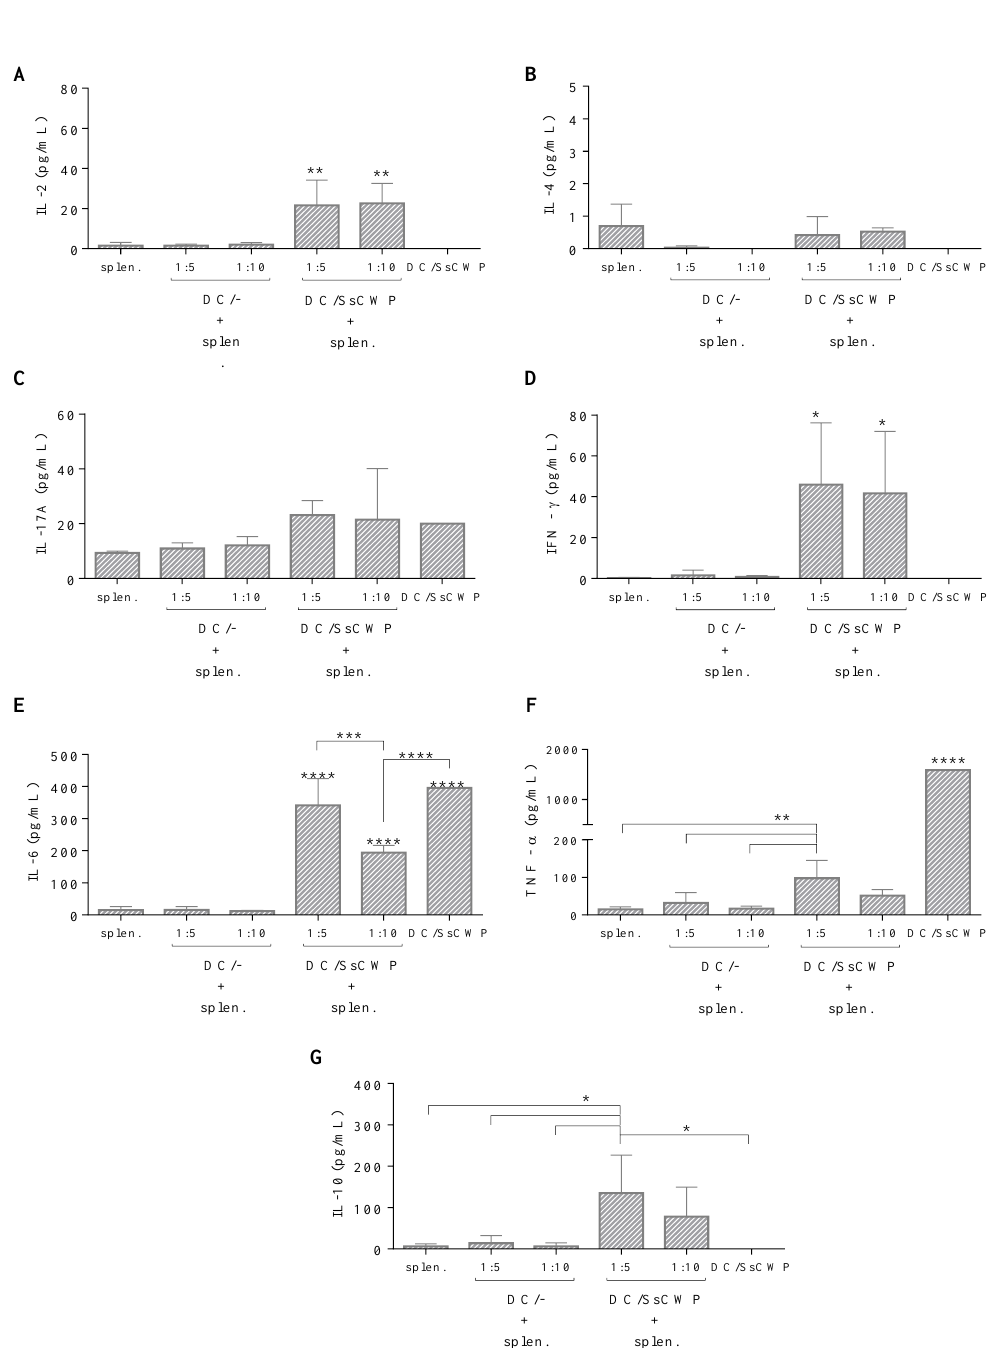
Figure 2. Measurement of cytokines released in the BMDC: splenocyte coculture supernatant. Values are presented as the mean ± SD of four animals. Asterisk indicates statistically significant difference between groups: * (p < 0.05), ** ( p < 0.01), *** ( p < 0.001), and **** ( p < 0.0001) as